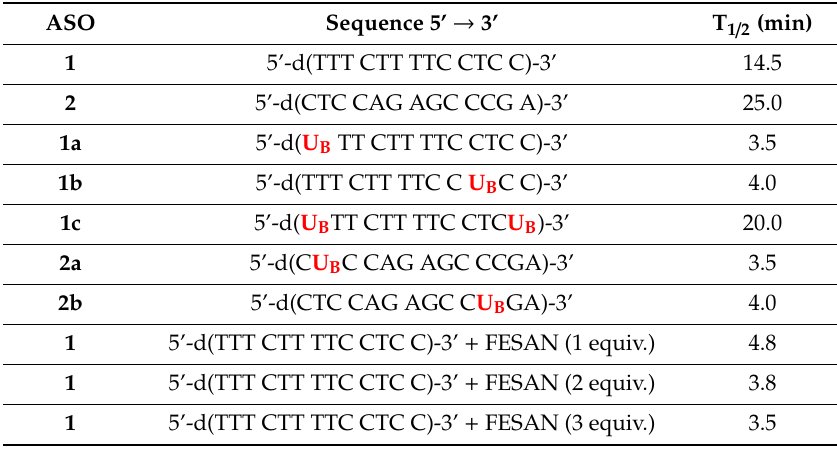
(T 1 / 2 ) are given for the hydrolysis reactions carried out in the presence of svPDE. Figure 8. Analysis of the hydrolysis rate of oligonucleotide 1 (1 equiv.) in the svPDE-assisted reaction carried out in the presence of 0, 1, 2 or 3 equivalents of metallacarborane. The % content of intact 1 was calculated after 0, 5 and 15 min of hydrolysis based on the relative peak intensities in the MALDI-TOF MS spectra. The sums of the relative intensity of the peaks corresponds to the intact oligomers and their two major fragments (12 nt and 11 nt) were taken as 100% at each time point. SD± values are marked. The roughly estimated T 1/2 values were assessed, as shown.